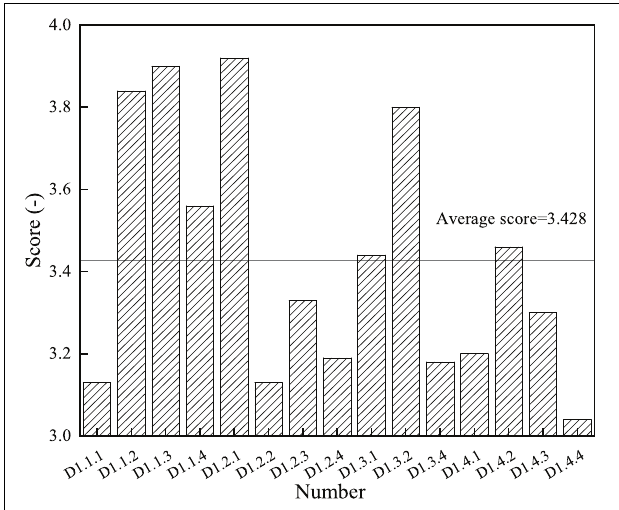
FIGURE 4 | Scores of entrepreneurship of college students.